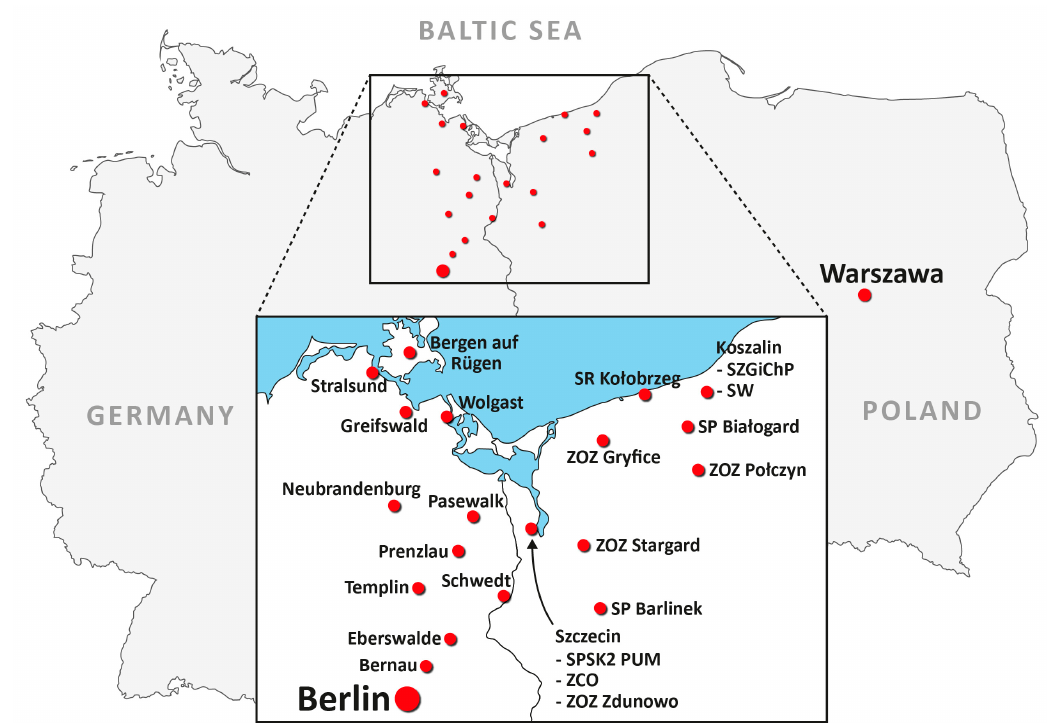
Figure 3. Geographical distribution of hospitals on both sides of the German–Polish border. Berlin, Warsaw and the Baltic Sea are also indicated for the better visualisation of the project.